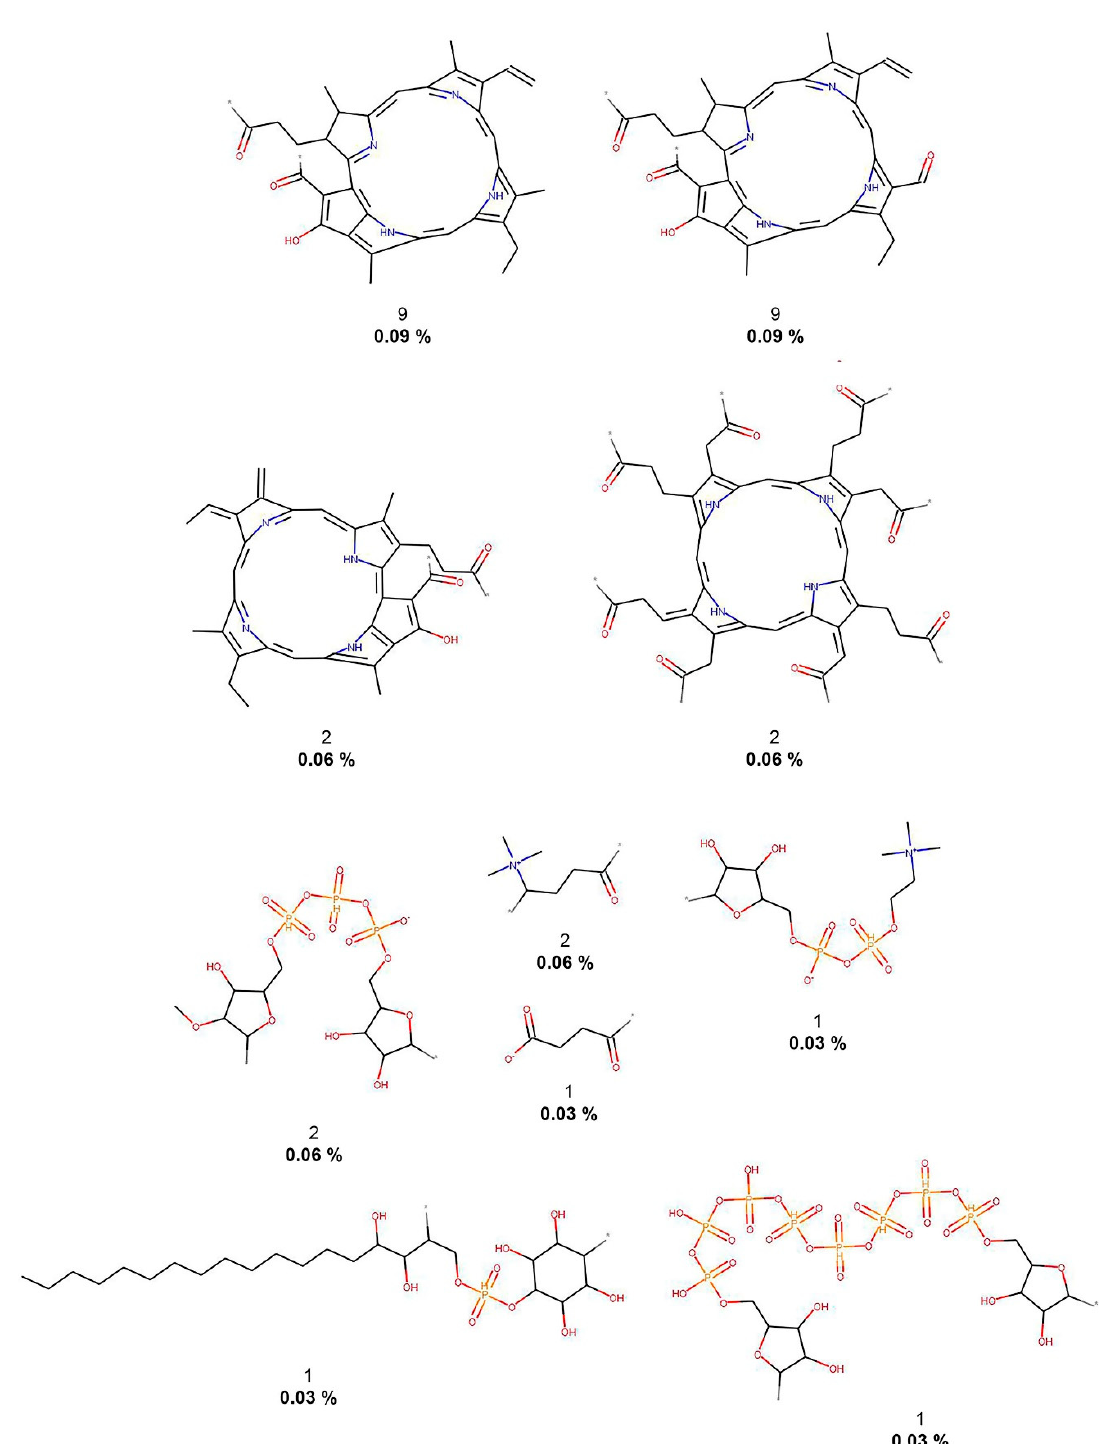
Figure 3. The 10 most frequent and unique FooDB fragments. Frequency (regular font) and proportion (bold font) are listed below the chemical structures.